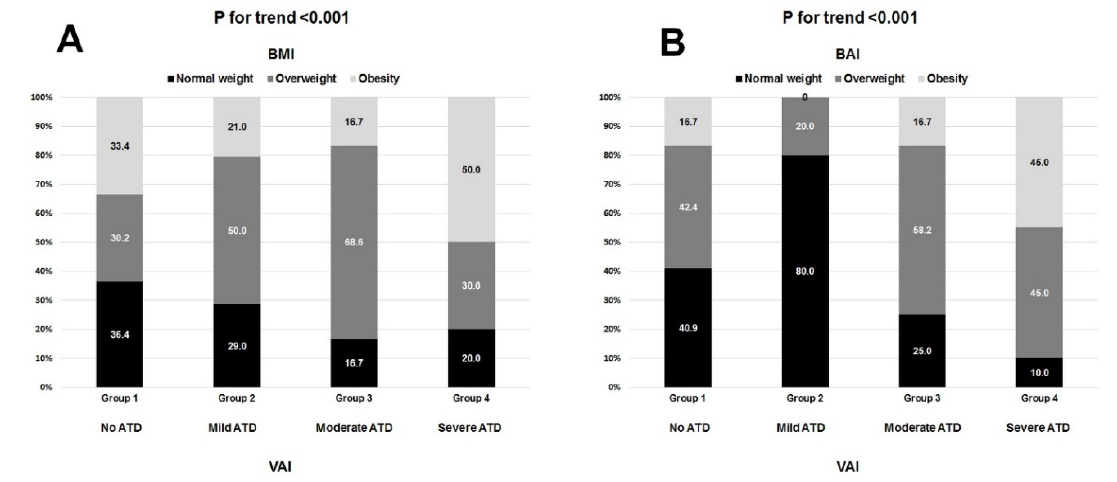
Figure 3. The distribution of BMI-defined ( A ) and BAI-defined ( B ) weight categories in respective adipose tissue dysfunction (ATD) types defined by VAI.